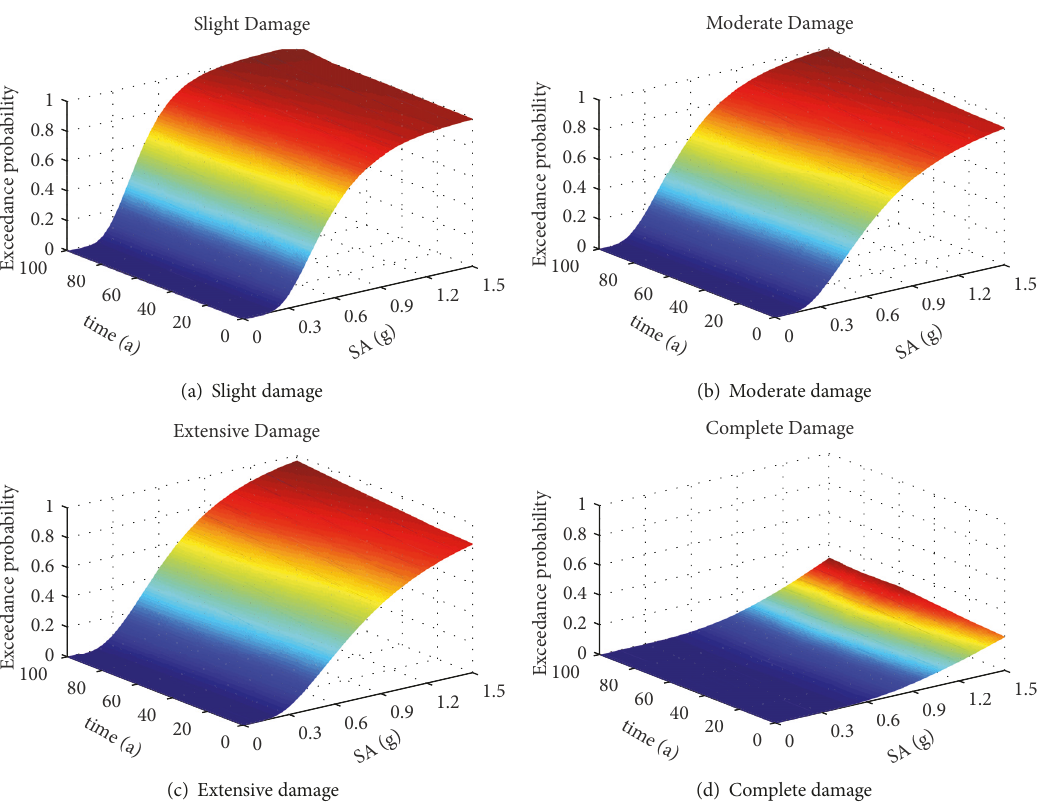
Figure 14: The vulnerability surfaces of 4 # pier under different damage states.